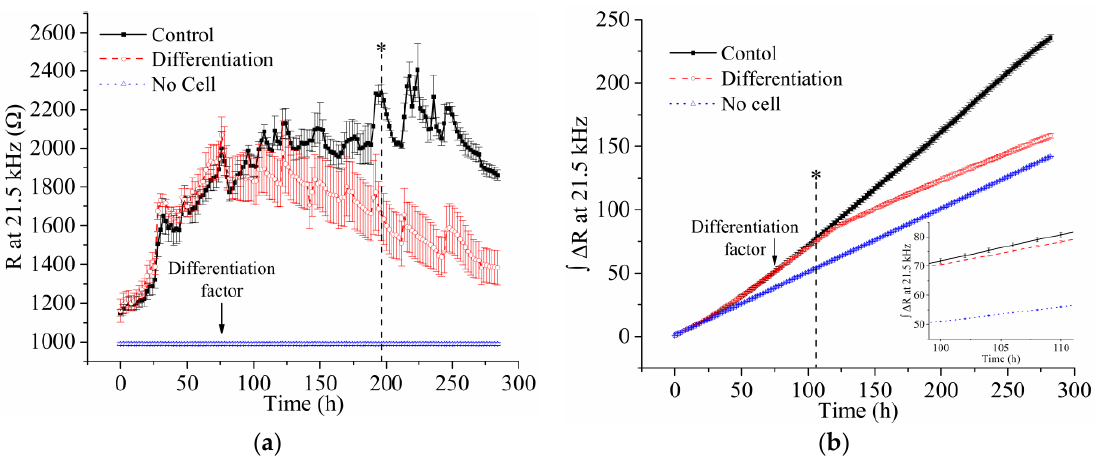
Figure 7. ( a ) Resistance (R) at 21.5 kHz and ( b ) integration of the resistance change (ΔR) at 21.5 kHz monitored during cell growth or differentiation. The average and standard error of the measured data ( n = 4) are represented by the symbol and bar, respectively.